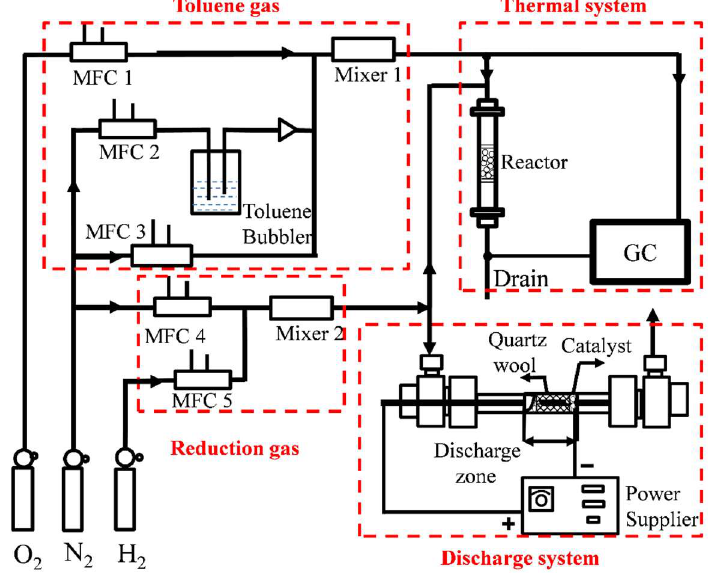
Figure 10. Schematic diagram of the experimental setup. The discharge condition was set for 3h with 4.8 W of input power, 1.77 kHz AC frequency, catalyst amount was fixed at 0.5